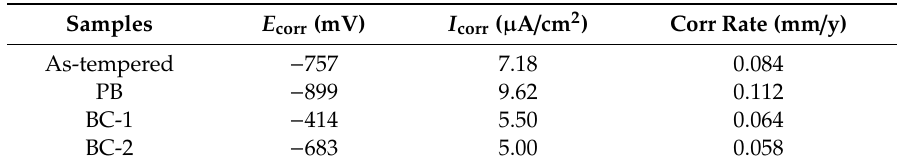
Figure 10. Potentiodynamic polarisation curves of various samples. Table 2. Corrosion potential ( E corr ), corrosion current density ( I corr ), and average corrosion rate (Corr rate) of various samples.